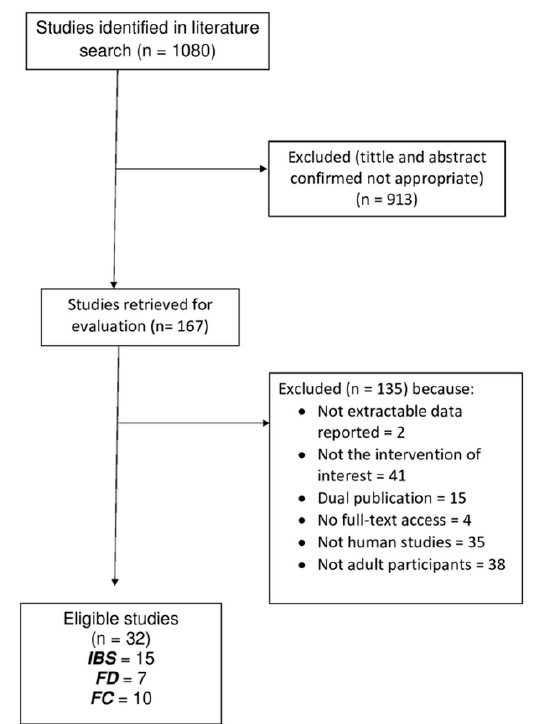
Figure 2. Flow diagram of studies evaluated in the